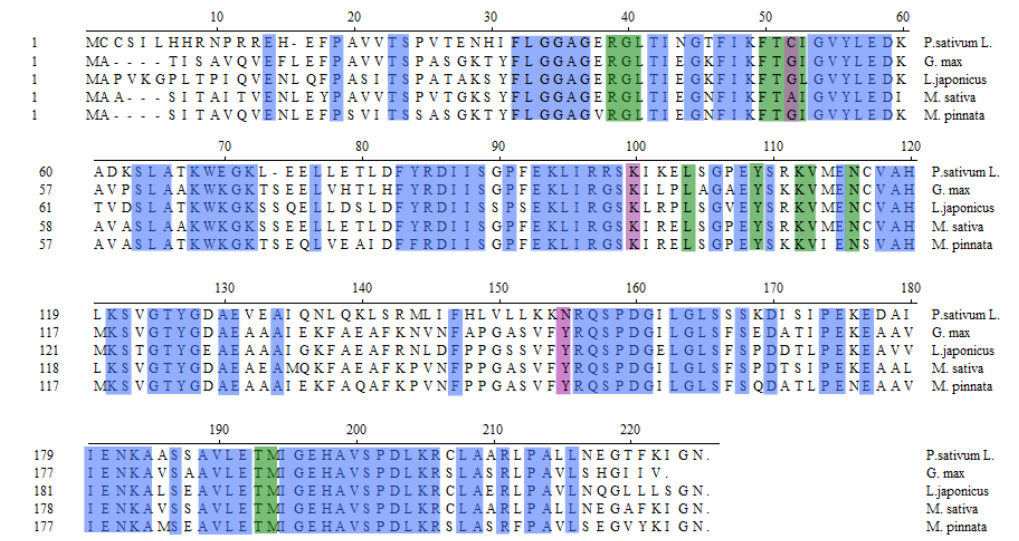
Figure 4. Peptide sequence alignment to compare MpCHI protein with four other leguminous CHIs. Residues of the (2 S )-naringenin binding (green) and residues of the active site hydrogen bond network (purple) are highlighted according to previous report. Other conserved residues are marked in